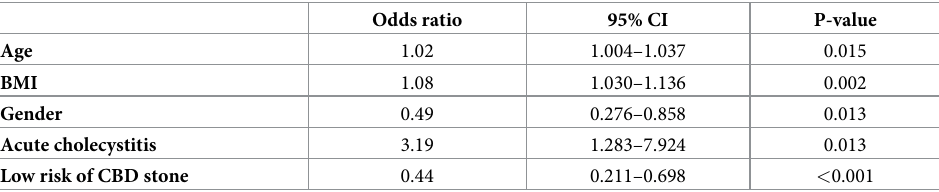
Table 5. Multivariate analysis of predictors of IOC